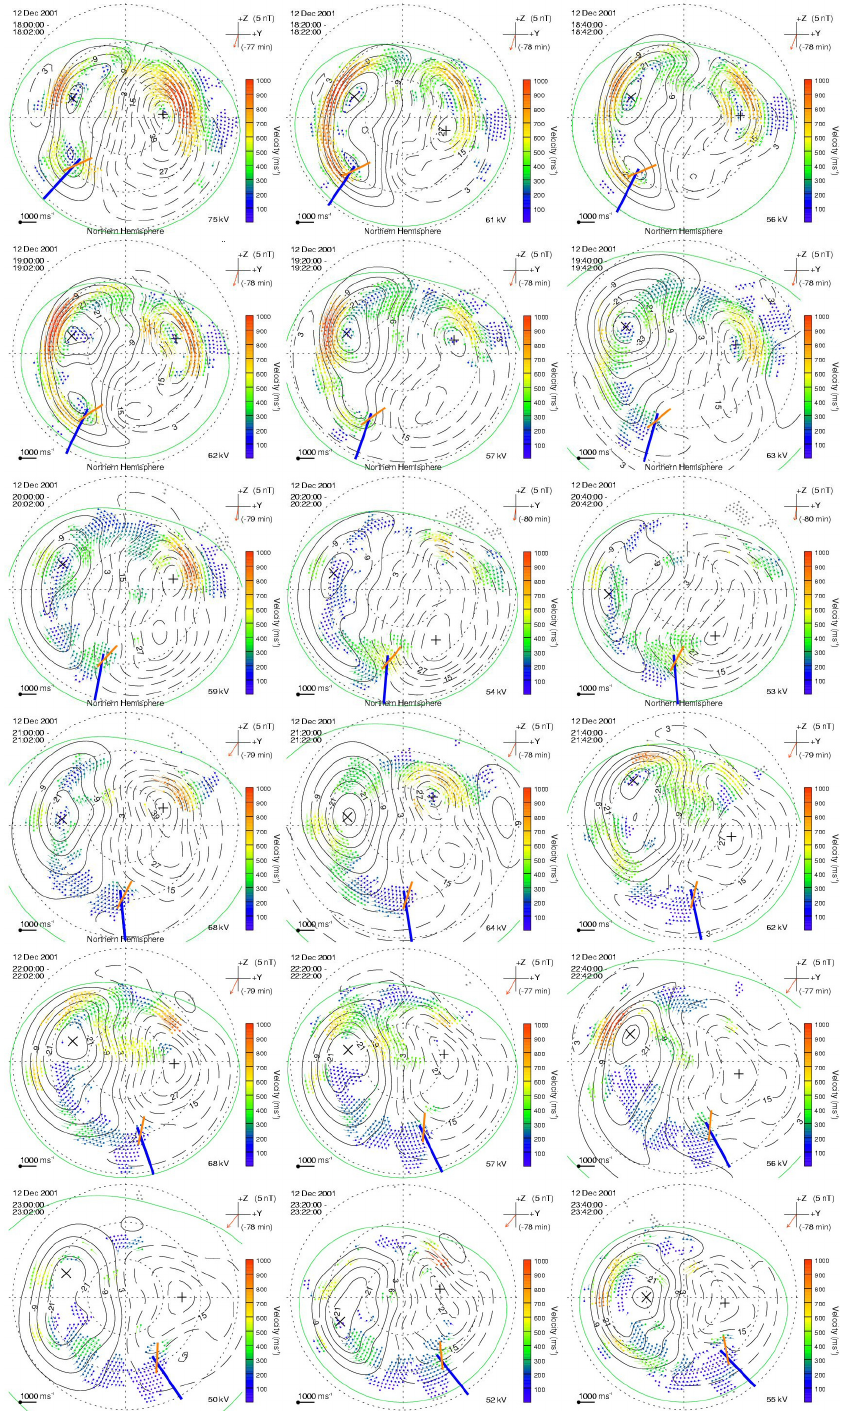
Fig. 2. SuperDARN electric potential patterns at 20 min intervals between 18:00UT and 23:40UT on 12 December 2001 as a function of geomagnetic latitude and magnetic local time. Magnetic noon is at the top of each panel with dusk and dawn on the left- and right- hand sides respectively. Magnetic latitude is indicated by the grey dashed circular lines in 10.0 ◦ increments with 60.0 ◦ MLAT at the outer circumference and the magnetic pole at the centre of each panel. The orange line on each panel indicates the intersection of the 32m-dish ESR beam observing at an azimuth of 185.3 ◦ and elevation 30.0 ◦ . The northern extreme of the line is at ground level, and the equatorward extreme is at an altitude of 600km. The blue line indicates the intersection of beam 6 of the SuperDARN radar at Hankasalmi,